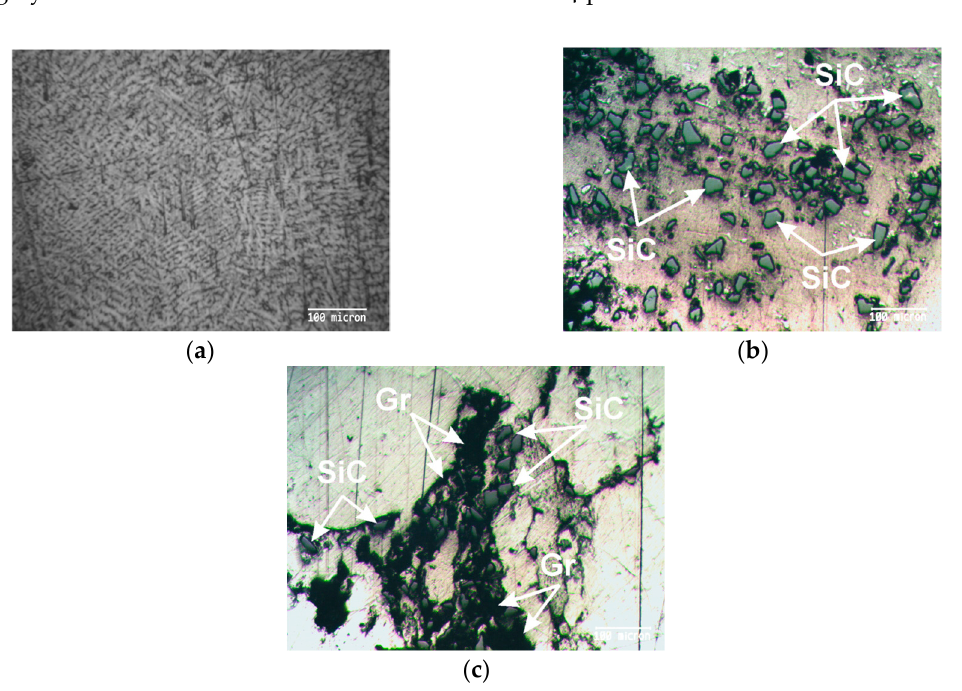
Table 1. The chemical composition of ZA27 alloy.